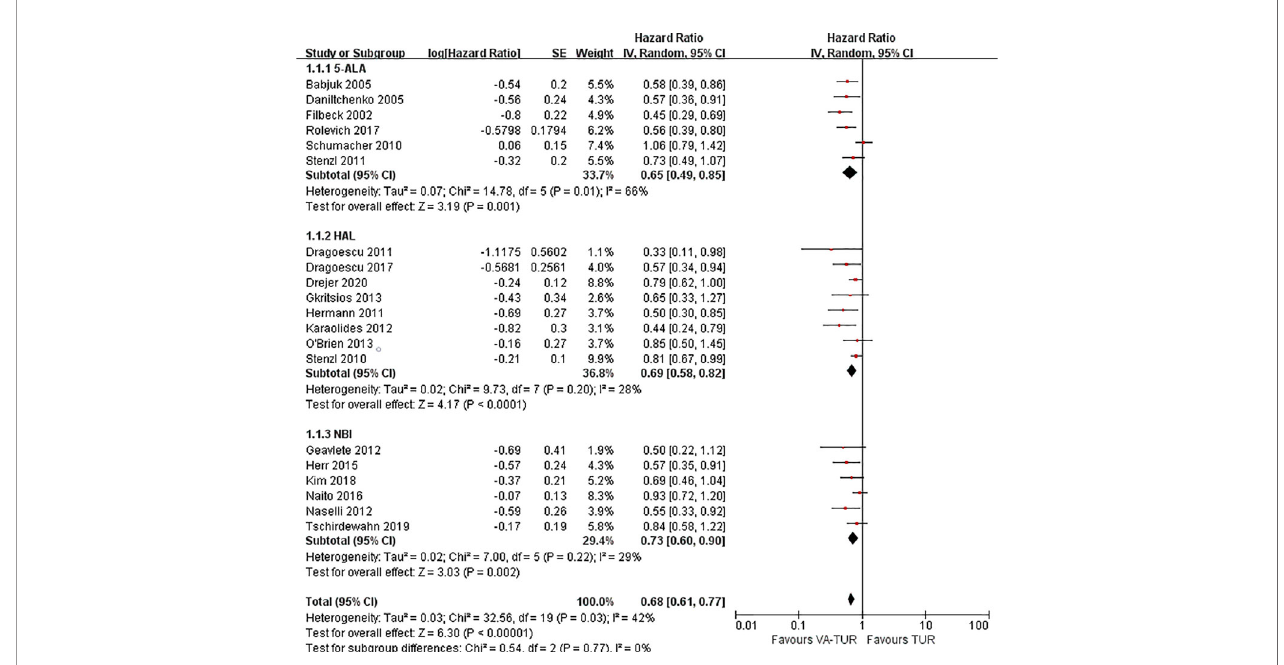
FIGURE 3 | Forest plot of RFS of VA-TUR versus TUR subgrouped by types of visualization methods.